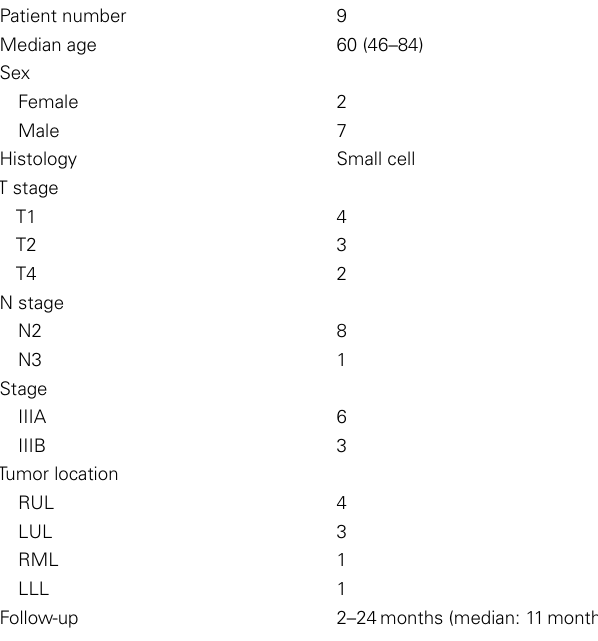
Table 1 | Patient characteristics